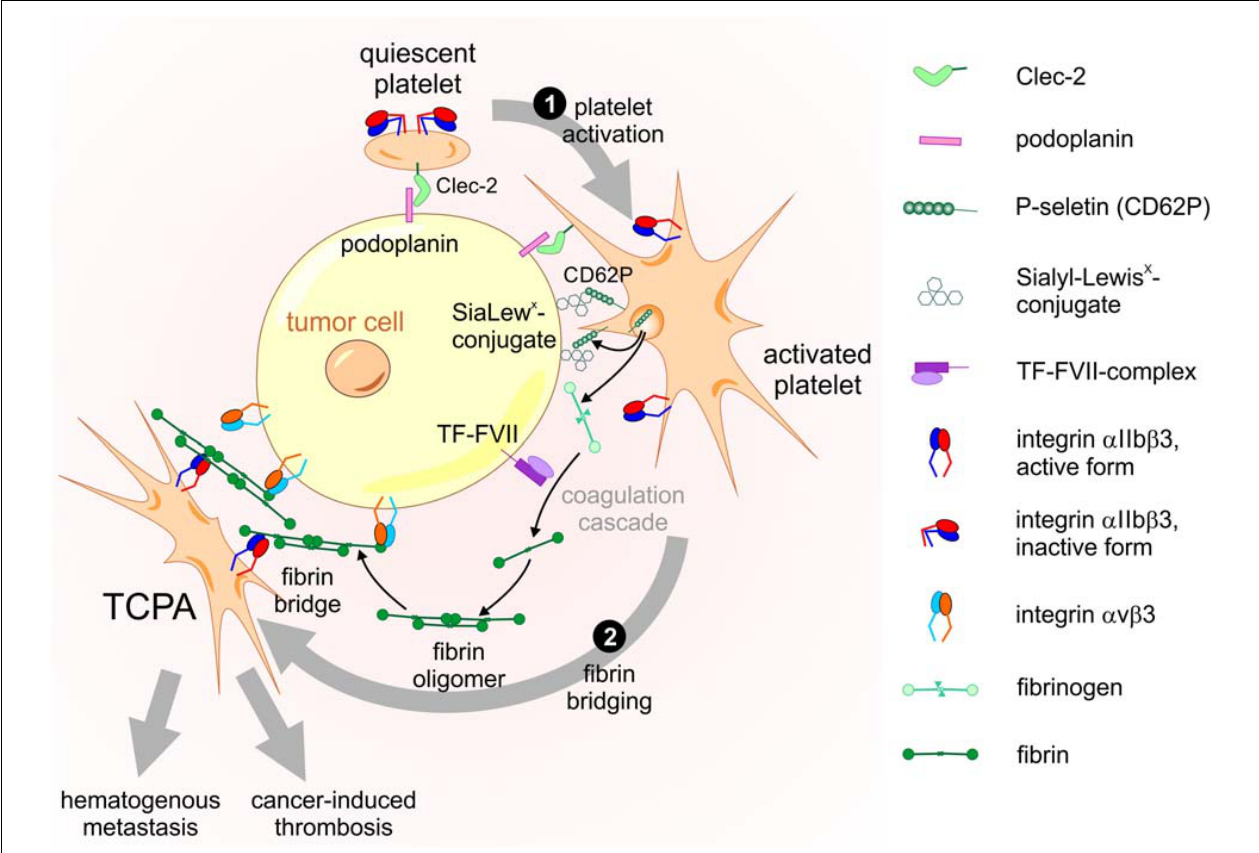
FIGURE 3 | Molecular components and activation steps of the TCPA formation cascade. The cascade of TCPA formation consists at least of the following two steps. (cid:182) Platelet activation triggered by Clec-2-podoplanin interaction results in degranulation with surface exposure of P-selectin, release of fibrinogen and conversion of integrin α IIb β 3 into an active conformation. (cid:183) Fibrin bridging of platelets and tumor cells requires cleavage of fibrinogen to fibrin by the extrinsic coagulation pathway initiated by the TF-FVII complex on tumor cells. Fibrin molecules, aggregated in a network, are bound by α V β 3 and α IIb β 3 integrins on tumor cells and platelets, respectively, allowing a stable mechanical bridge within the